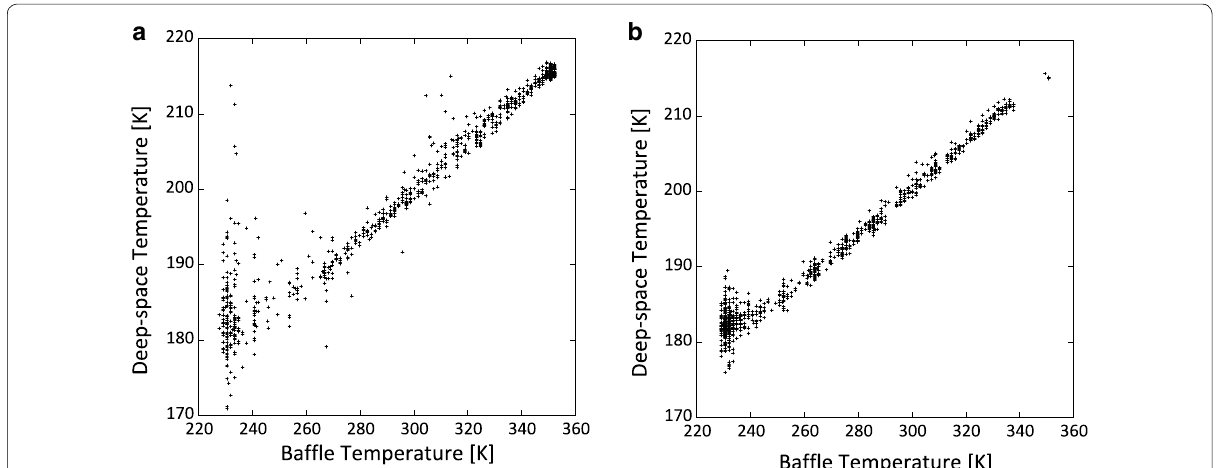
Fig. 3 Distribution of the brightness temperature retrieved from the deep‑space area in LIR images with m baffle temperature. a Data acquired from March to September 2016 with LIR turned on 15 min before the beginning of each observation. b Data acquired from October to December 2016 with the power supply unit of LIR continuously powered on (since in October 2016)